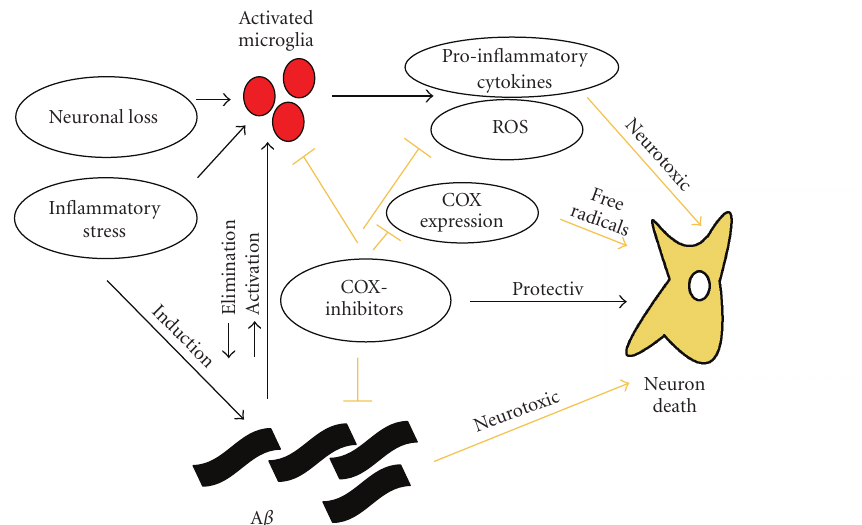
Figure 1: possible interactions of COX-inhibitors and Alzheimer‘s disease pathology. The fair arrows show neurotoxic properties of A β , COX-expression cytokines. In addition it is indicated that COX-inhibitors block COX-expression, activated microglia, ROS, and A β . ROS: radical oxygen species; COX: cyclooxygenase; A β : amyloid β